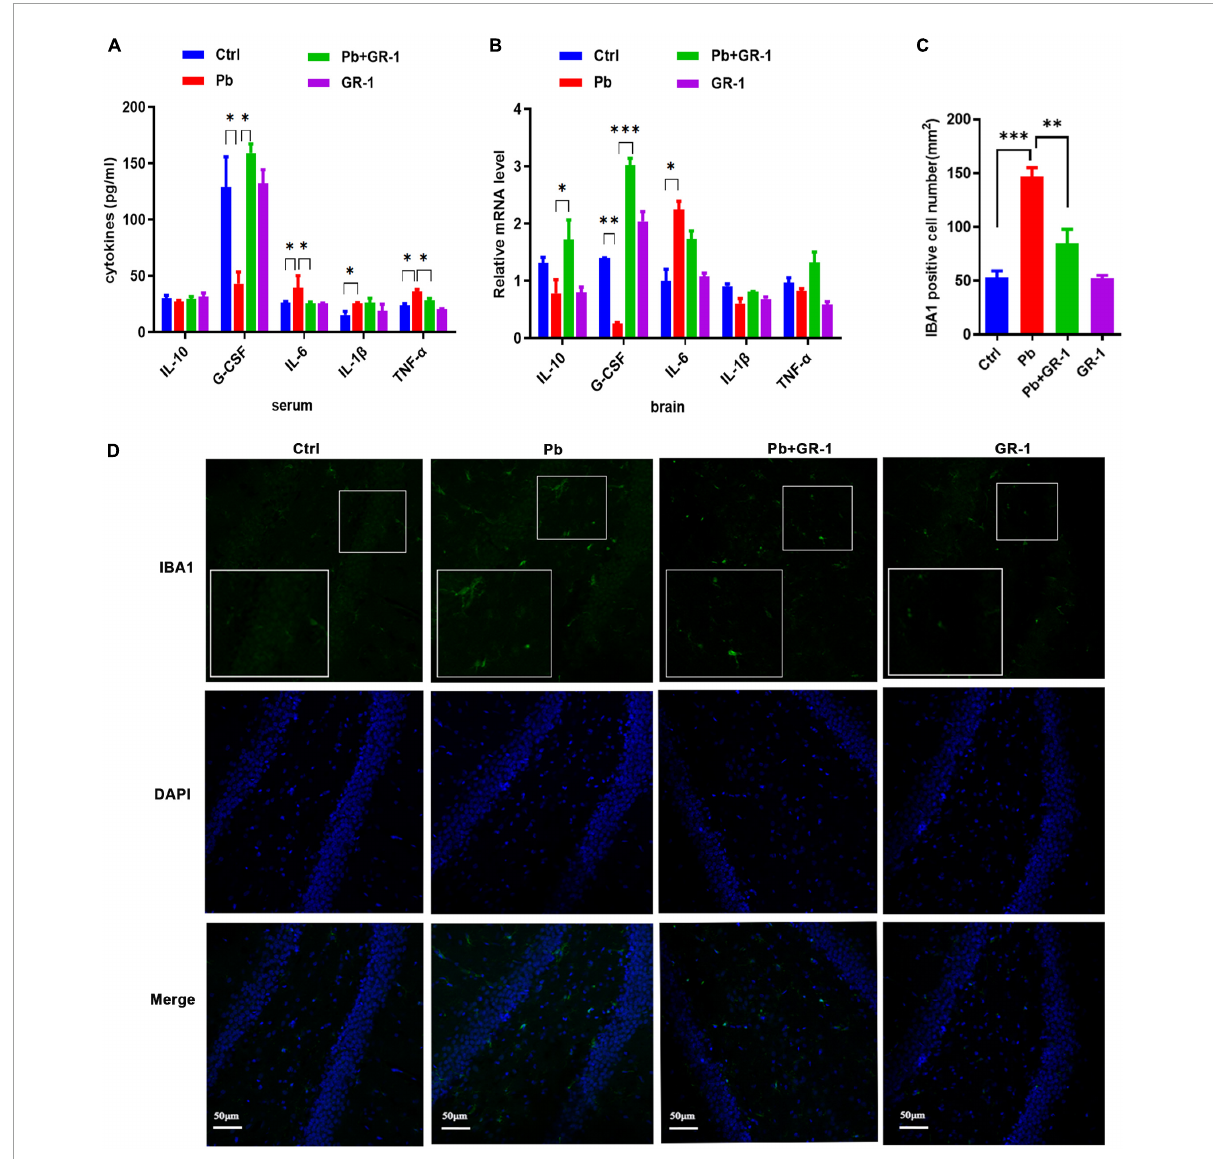
FIGURE6 Lactobacillus rhamnosus GR-1 treatment reduced microgliosis and inflammation in the hippocampus of Pb-exposed rats. n = 6. (A) The serum cytokine expression of Ctrl, Pb, Pb + GR-1, and GR-1 groups, including IL-1 β , IL-6, IL-10, TNF- α , and G-CSF. n = 6. (B) The mRNA expression levels of cytokines in the hippocampus, such as IL-1 β , IL-6, IL-10, TNF- α , and G-CSF of the indicated groups. n = 6. (C) The number of IBA1-positive cells of each group. n = 3. (D) The immunohistochemistry staining was performed to detect IBA1 expression of the hippocampus in the indicated groups. n = 3. Data are shown as mean ± SEM. ∗ p < 0.05, ∗∗ p < 0.01, ∗∗∗ p <